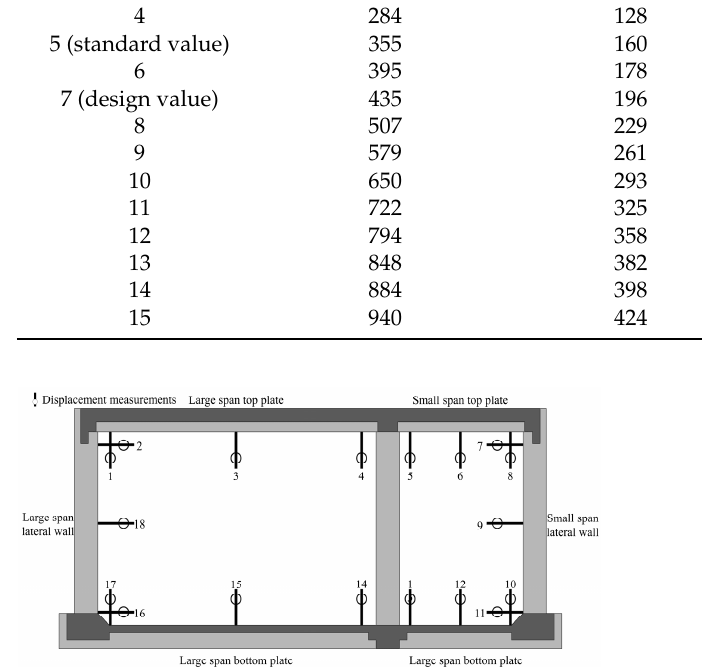
Figure 4. Test loading devices.